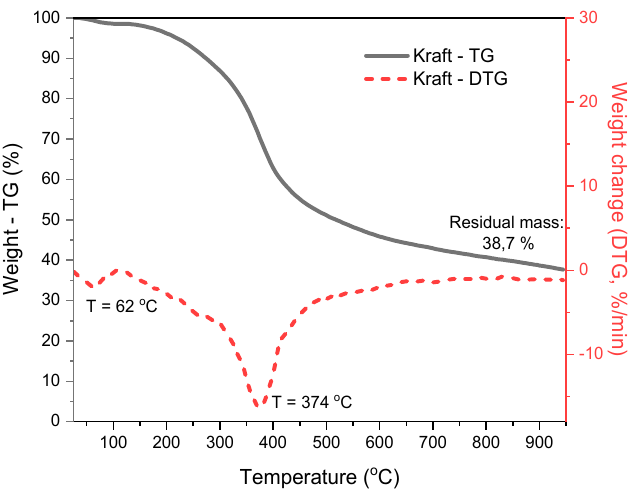
Figure 2. Kraft lignin Thermogravimetric (TG) and Derivative Thermogravimetric (DTG) curves .